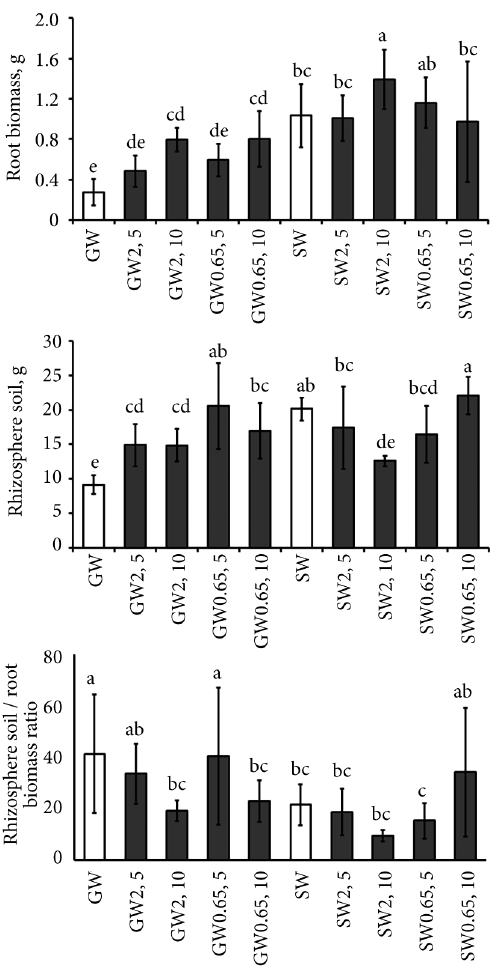
Figure 3. Mean±SD of root biomass (g), rhizosphere soil accumulation around roots (g) and rhizosphere soil/root biomass ratio of spinach in response to various treatments; GW-ground water, SW-wastewater, 2, 5-soil amended with large particle size biochar at 5% amendment rate, 2, 10-soil amended with large particle size biochar at 10% amendment rate, 0.65, 5-soil amended with small particle size biochar at 5% amendment rate, 0.65, 10-soil amended with small particle size biochar at 10% amendment rate. Bars with different letters indicate significant difference at P ≤ 0.05